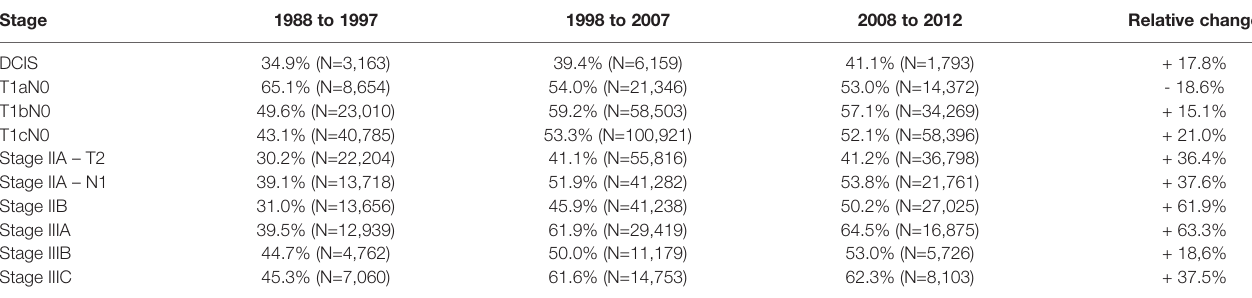
TABLE 2 | Proportion of patients treated with radiotherapy increased over time for various breast cancer stages but for T1aN0